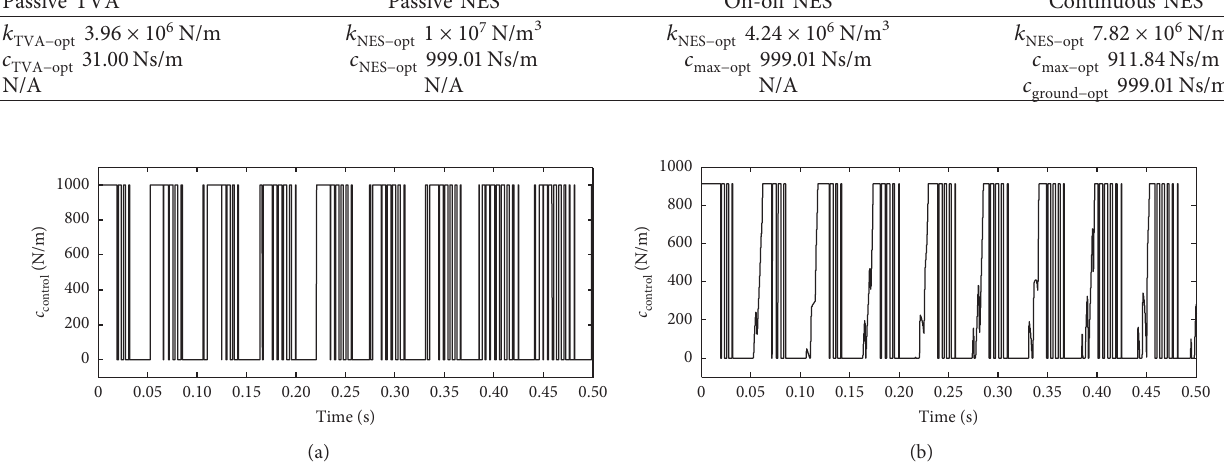
Figure 11: (a) Semiactive damping of on-off NES. (b) Semiactive damping of continuous